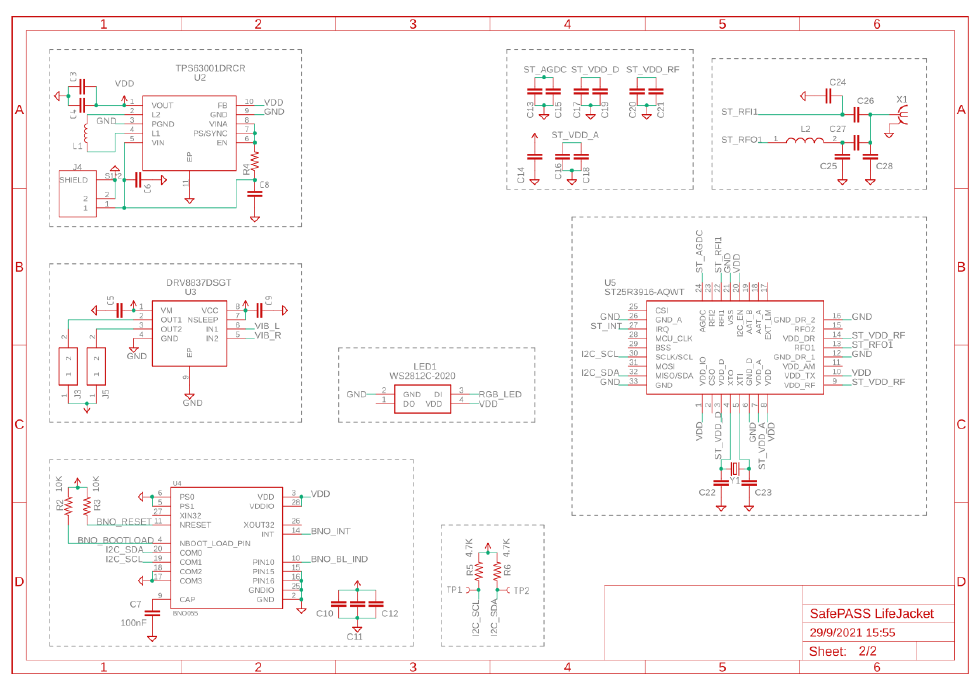
Figure A2. Main board schematic second part.